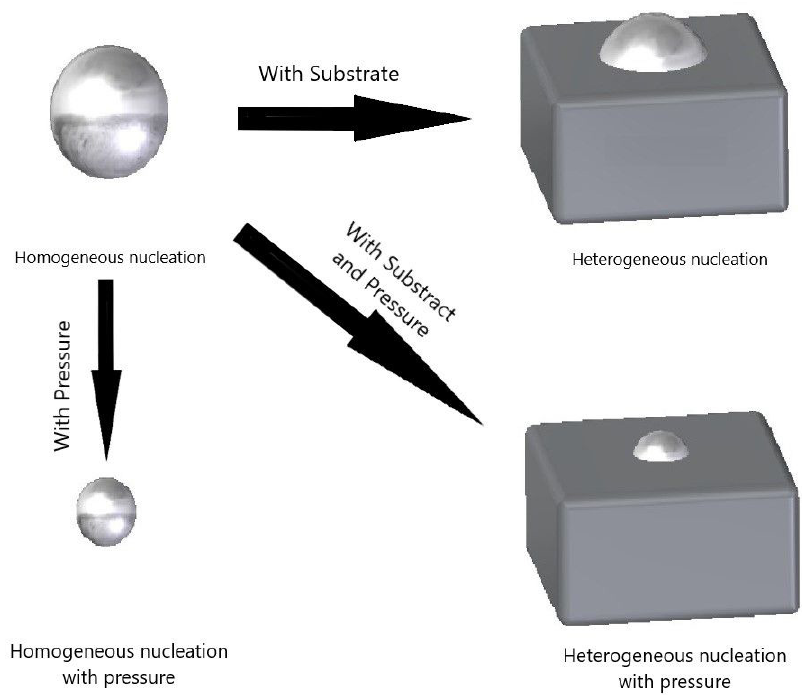
Figure 6. Schematic representation of the effect of pressure in combination with heterogeneous nucleation.